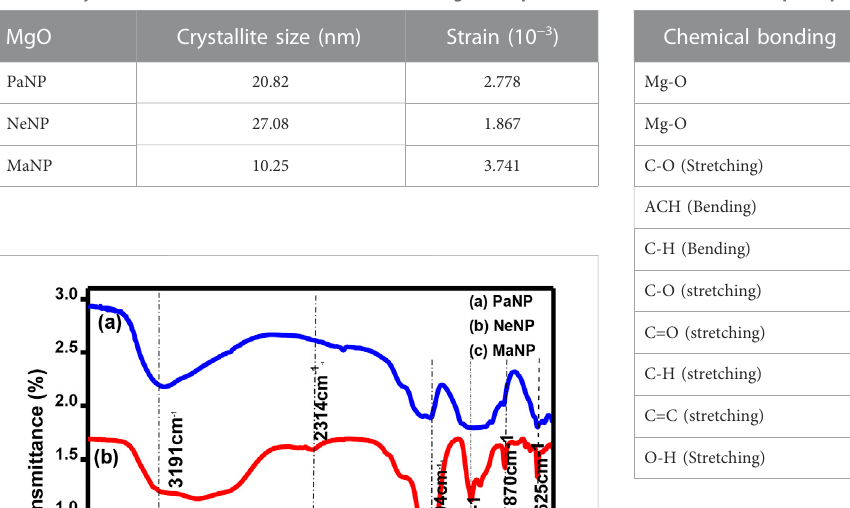
TABLE 2 The absorption peaks recorded for Pa, Ne and Ma